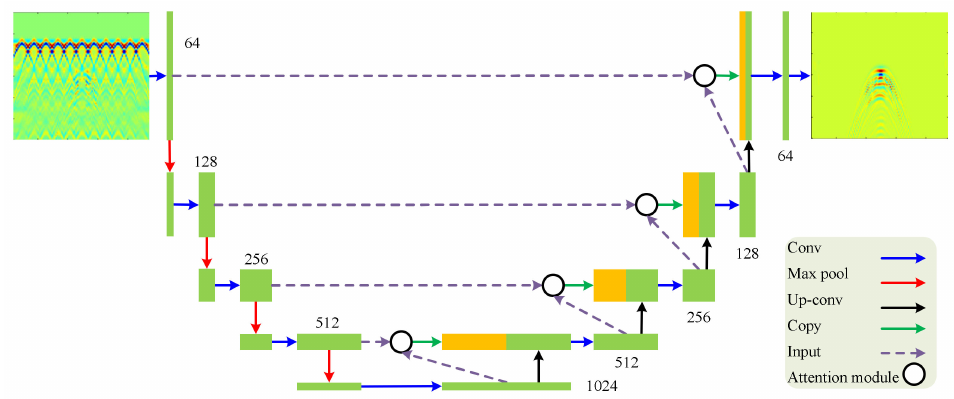
Figure 4. Added attention module from the Unet